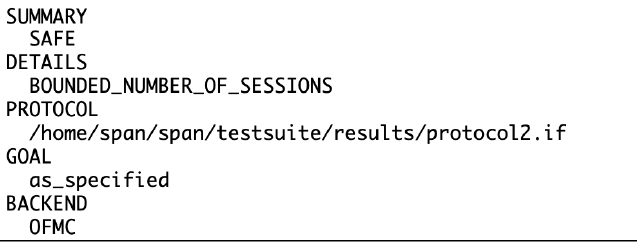
Figure 14. Output of OFMC backend forhigh security